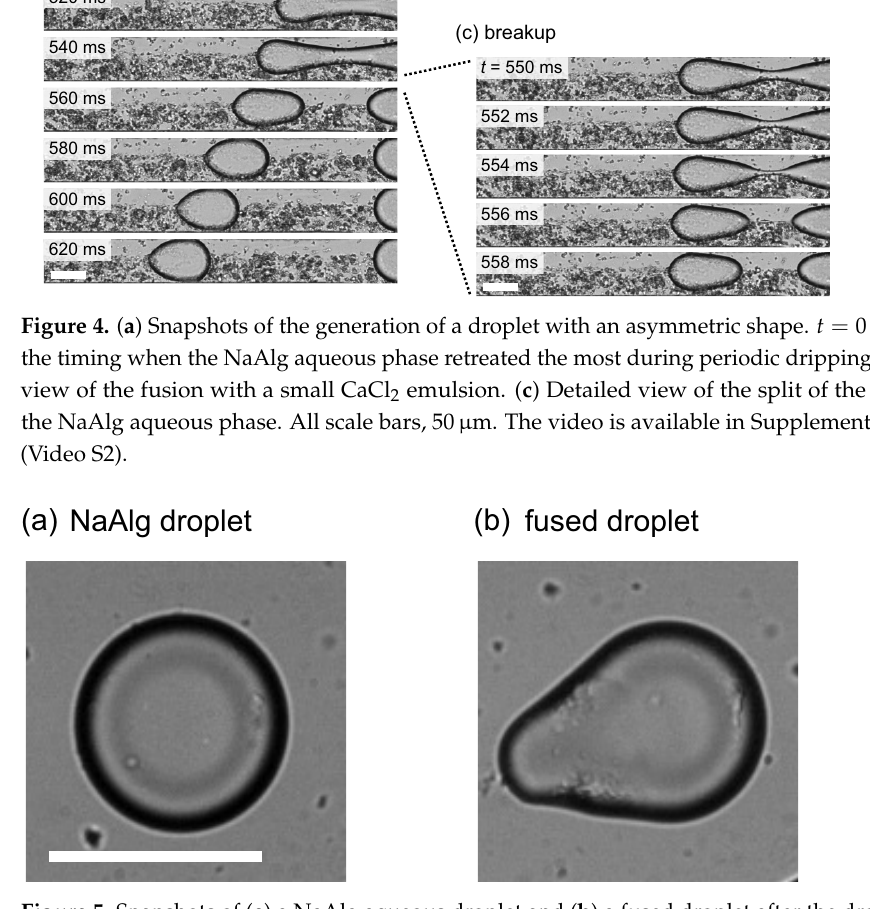
Figure 5. Snapshots of ( a ) a NaAlg aqueous droplet and ( b ) a fused droplet after the droplets entered the wide part of the microchannel. Scale bar, 50 µ m. The videos corresponding to ( a , b ) are available in Supplementary materials (Video S3 and Video S4,